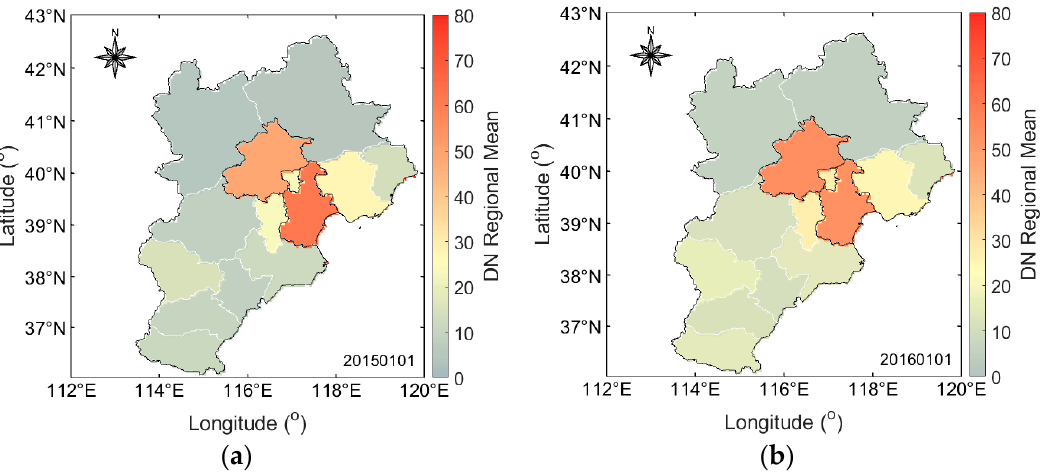
Figure 3. Regional mean value results of VIIRS S-NPP luminous data. The left and right figures show the regional mean value results of luminous data on ( a ) 1 January 2015 and ( b ) 1 January 2016, respectively.